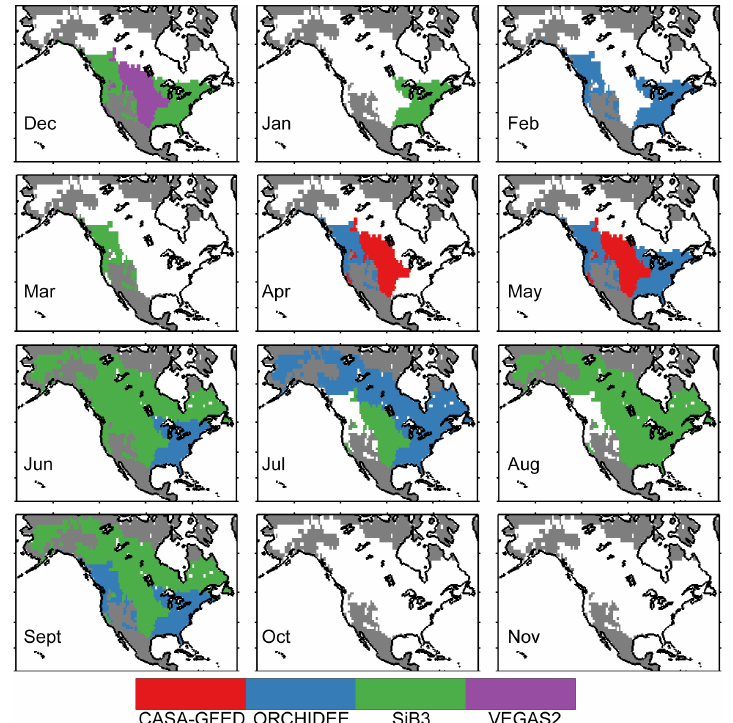
Figure 8. The TBM that explains the most variability in atmospheric measurements for a given biome-month, as identified by the RD-all- ξε experiment. Grey shading represents biomes that were determined to be not sufficiently well constrained by available atmospheric